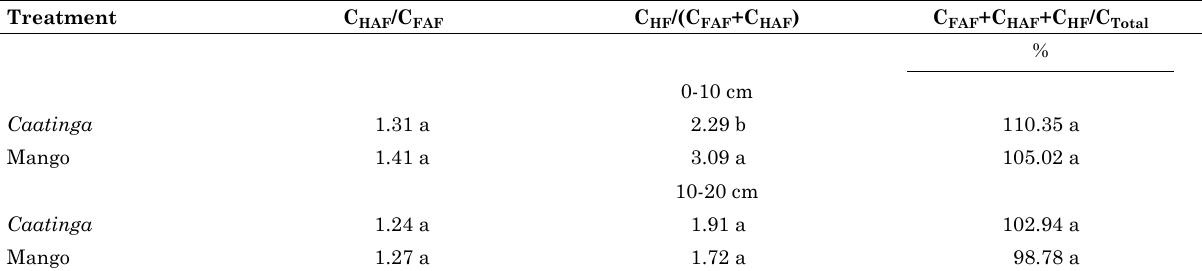
C FAF : Carbon of the fulvic acid fraction; C HAF : Carbon of the humic acid fraction; C HF : Carbon of the humin fraction. In the columns, values followed by the same letter do not differ among themselves by the Student t test (α = 5